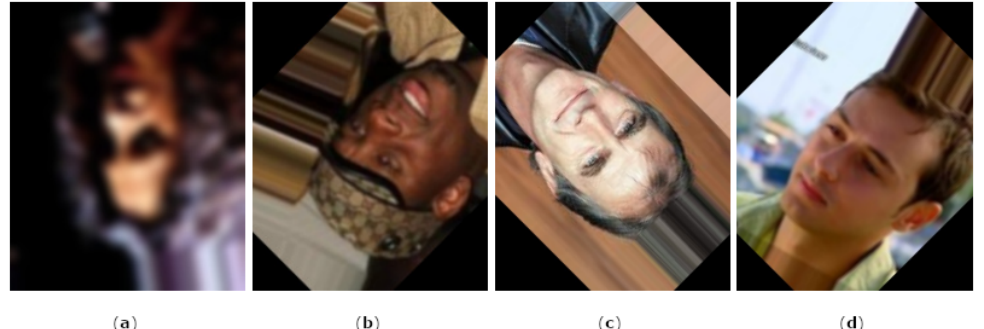
Figure 11. Real samples classified as fake by the “PRA Lab—Div. Biometria” method. In particular: ( a ) 1420.jpg, ( b ) 1794.jpg, ( c ) 3938.jpg, ( d ) 4184.jpg and other real images from the competition dataset